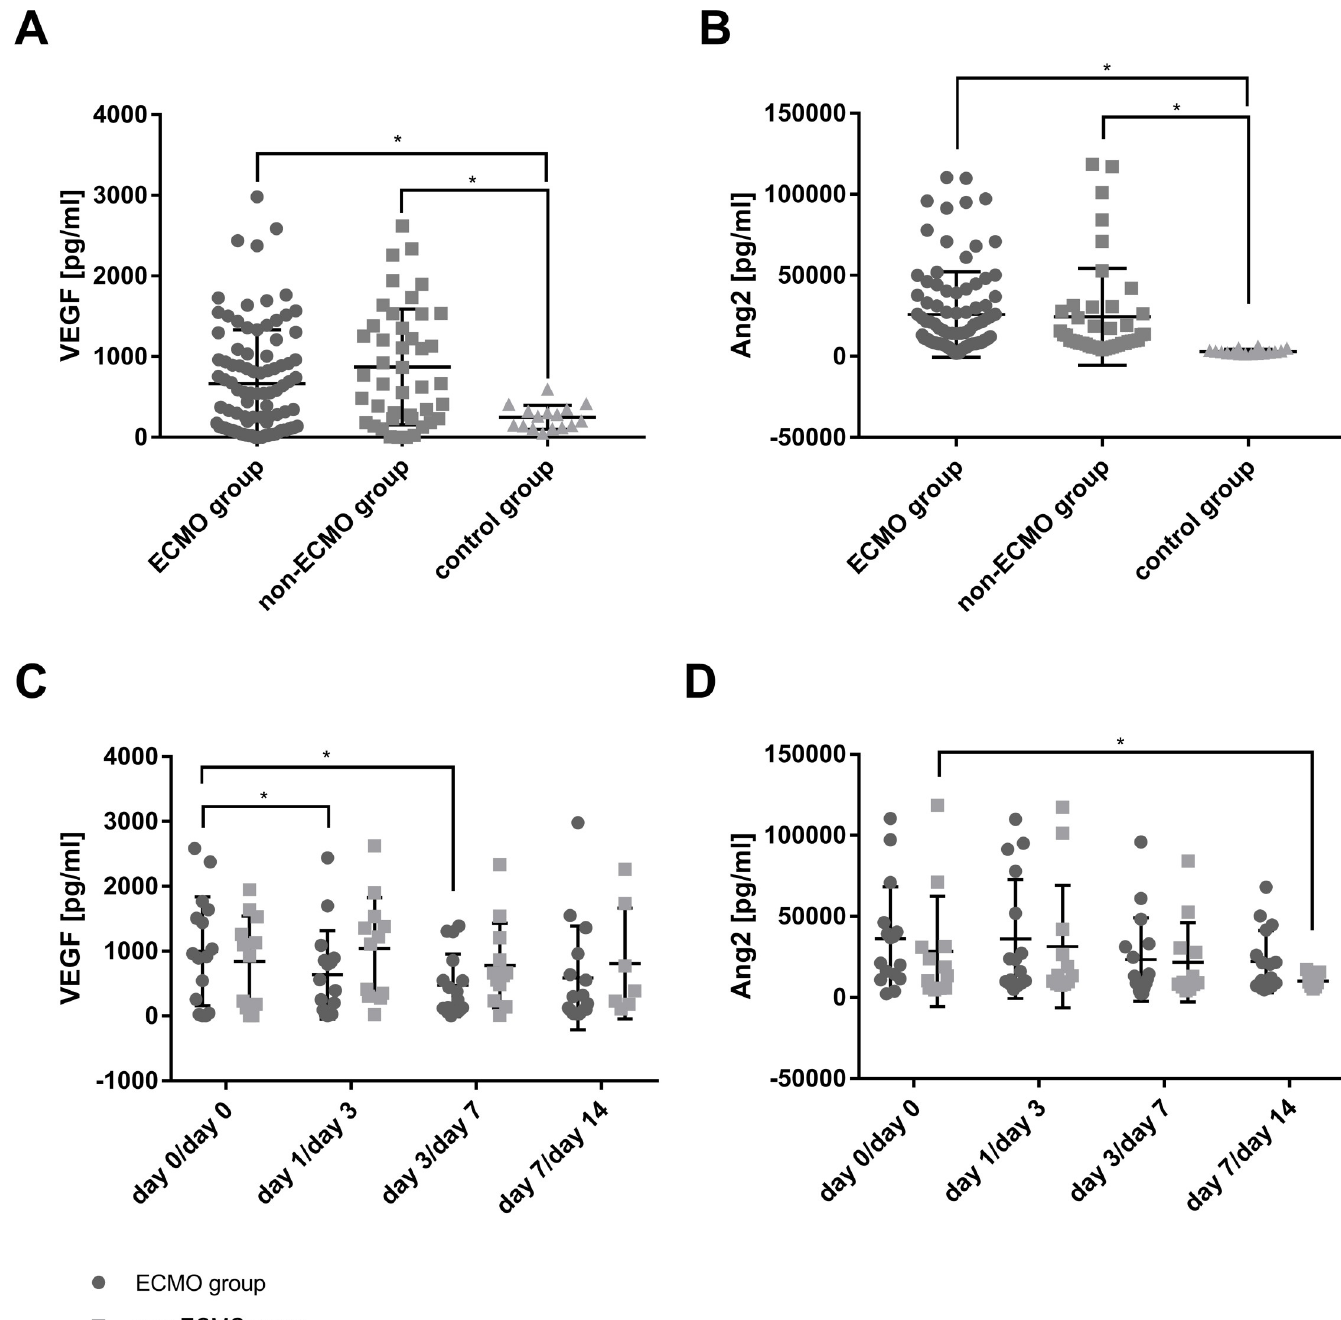
Fig 2. Serum levels of mobilizing factors. The averaged levels of vascular endothelial growth factor (VEGF) and angiopoietin 2 (Ang2) (panel A and B) and for each timepoint of blood sampling (panel C and D) (in the ECMO group at day 0, day 1, day 3 and day 7; in the non-ECMO group at day 0, day 3, day 7 and day 14) are displayed. � marks a significant difference (p <